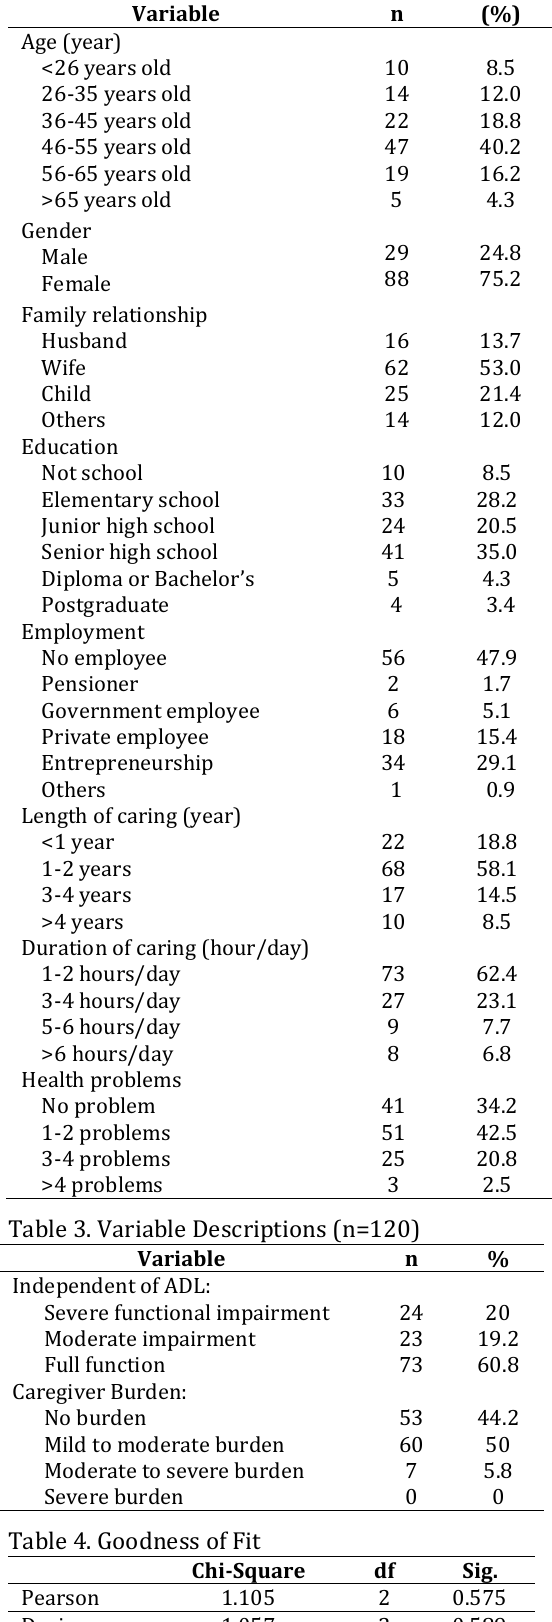
Table 2. Characteristics of the